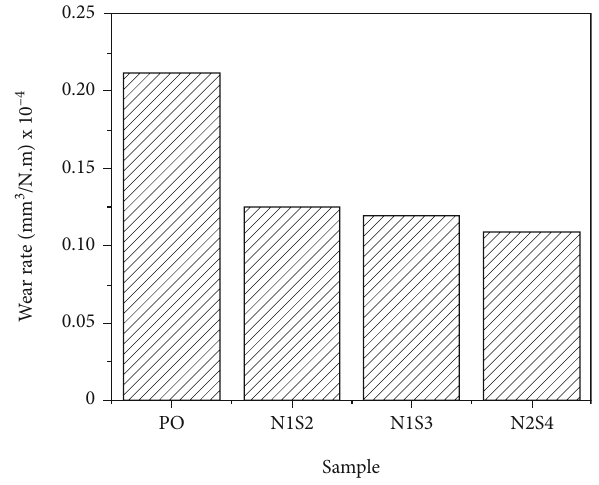
Figure 8: The wear rate for the lubricants under speed of 200 rpm and 5.5N